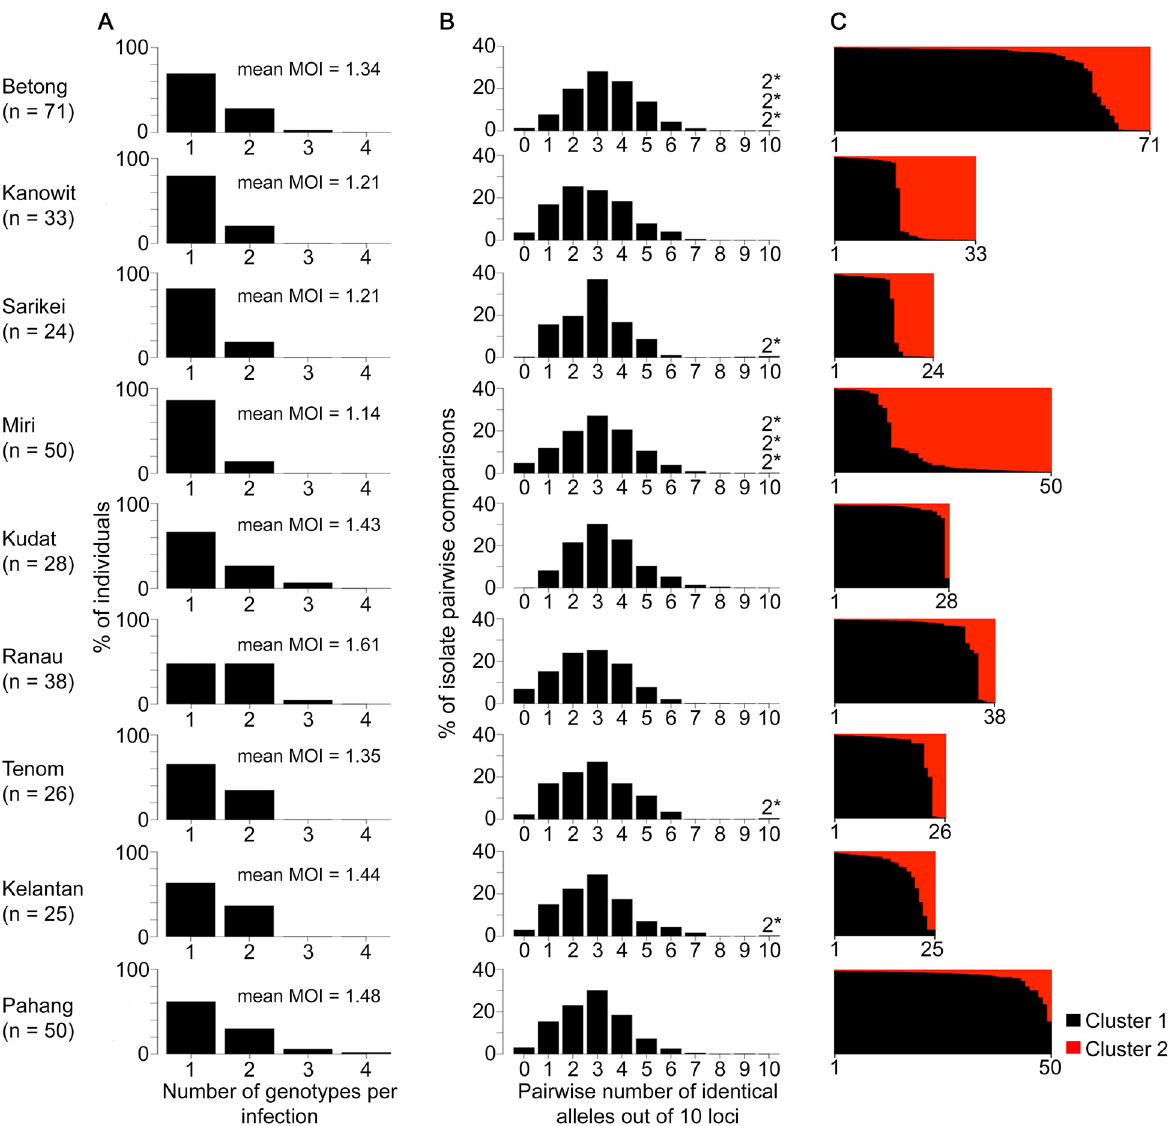
Fig 4. Diversity and genetic structure of P . knowlesi in human infections from nine different geographical locations. All P . knowlesi data for analysing multiple genotype infections, distribution of identical alleles between isolates and STRUCTURE analysis were derived from complete genotyping of 10 microsatellite loci. (A) Proportions of infections containing different numbers of genotypes (multiplicity of infection, MOI). Comparison across all 10 geographical locations including Kapit (data in Fig 2) showed no significant differences (Pearson ’ s X 2 with 10000 replicates, P = 0.096). (B) Distribution of numbers of identical alleles out of 10 loci in pairwise comparisons of infections. In six of the populations, a small number of pairs of identical multi-locus genotypes were seen as indicated with a label here (2 * ) and tabulated in detail in S4 Table. (C) Subpopulation clusters inferred by the Bayesian model-based STRUCTURE analysis with Cluster 1 (black) and Cluster 2 (red) corresponding to those identified in Fig 3 ( K = 2, Δ K = 174.94). Proportions of isolates assigned as Cluster 2 are highest at the sites in Sarawak (top four panels in the figure; locations of all sites are shown in Fig